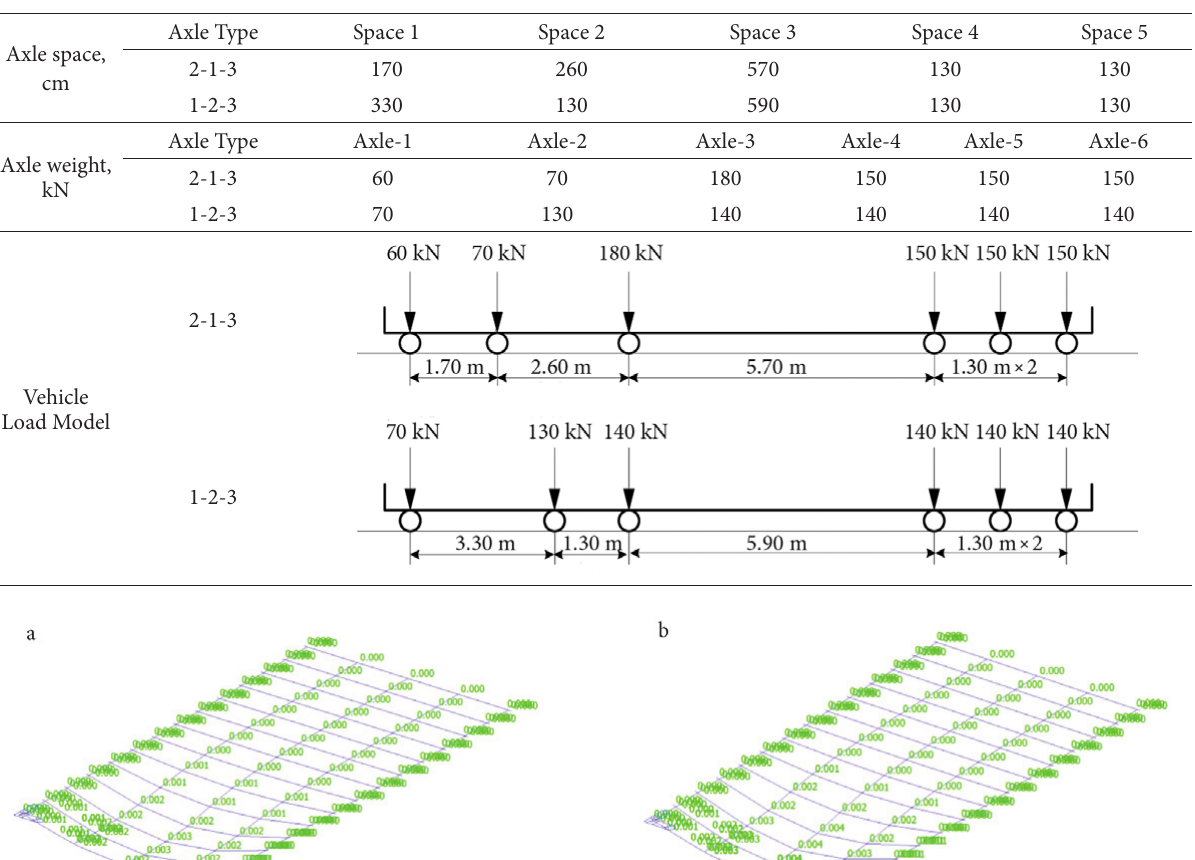
Fig. 14. All axles spacing of 2-1-3 type 6-axle vehicle Table 3. Vehicle load model of proposed 6-axle vehicle